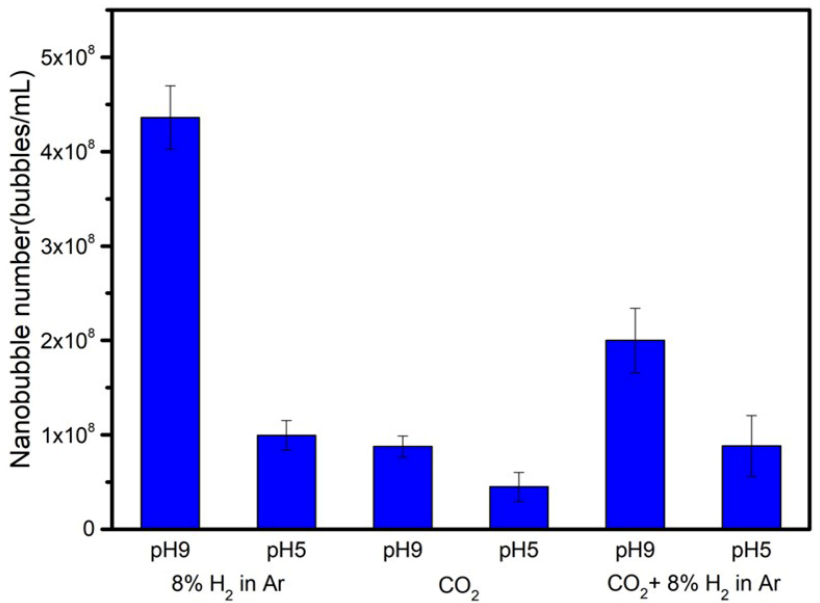
Figure 8. Nanobubble numbers at pH 9 and pH 5 for 8% H 2 in Ar, CO 2 , and CO 2 after 8% H 2 in Ar in 10 vol.% ethanol aqueous solution mixture after 20 days.